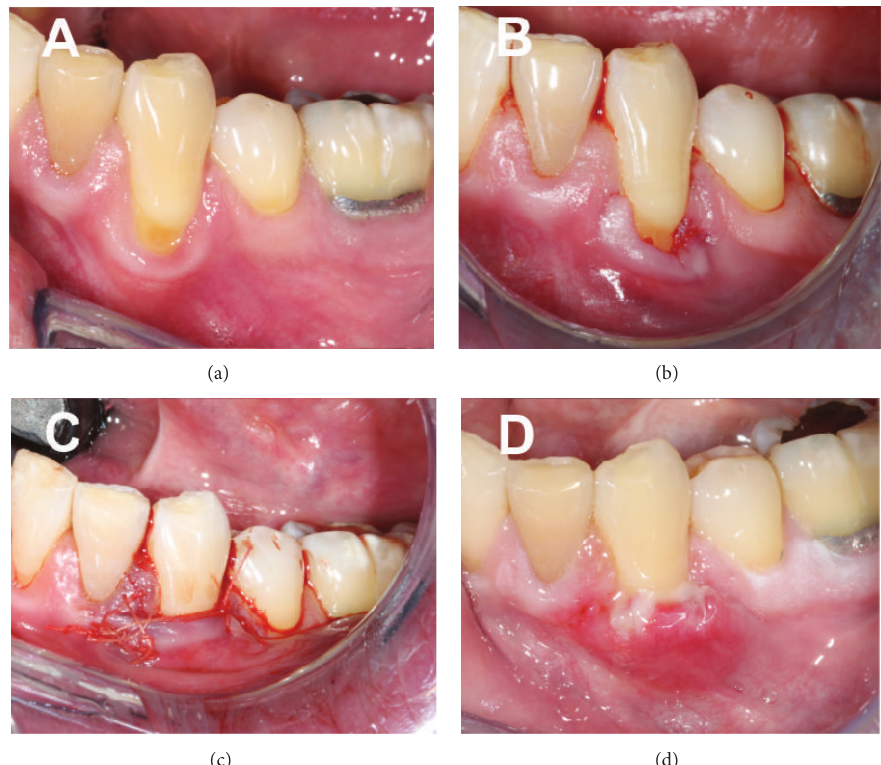
Figure 1: Clinical images. (a) Initial presentation; note Miller Class I recession defect on facial of the mandibular left canine; (b) pouch prepared; (c) SCTG surgery completed; (d) postoperative week 1